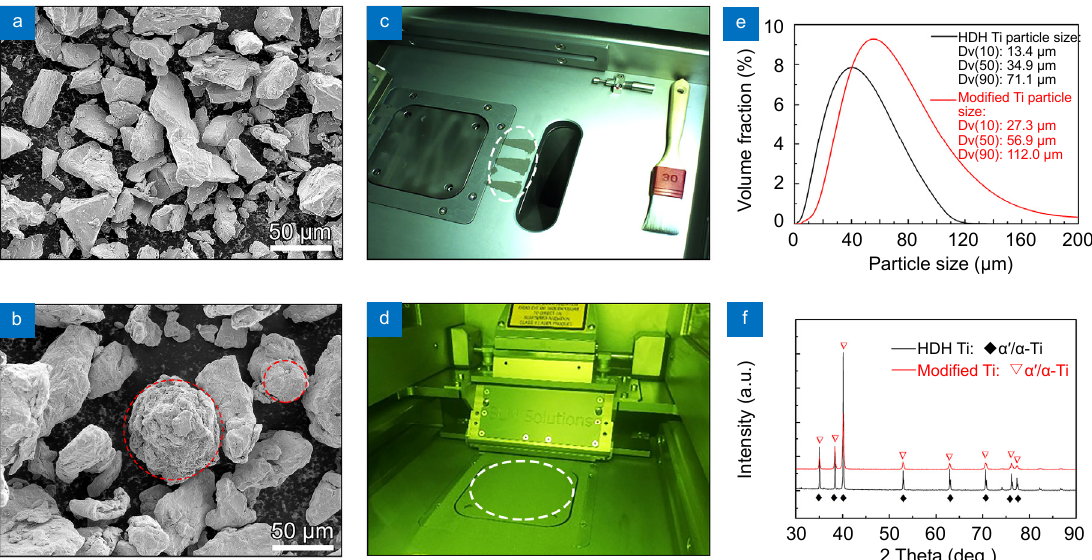
Fig. 2 | ( a ) SEM-SE image of unmodified HDH-Ti powder. ( b ) SEM-SE image of the modified HDH-Ti powder which shows near spherical morphology. ( c ) The powder spread record for the unmodified HDH-Ti powder (fails to spread onto substrate). ( d ) The powder spread record for the modified HDH-Ti powder (which is printable). ( e ) Particle size distribution before and after powder modification. ( f ) XRD results for the powders before and after powder modification. Table 4 | Chemical compositions of the unmodified and modified HDH-Ti powder, and the as-printed Ti using the modified HDH-Ti and as-purchased spherical Ti powder. Mo